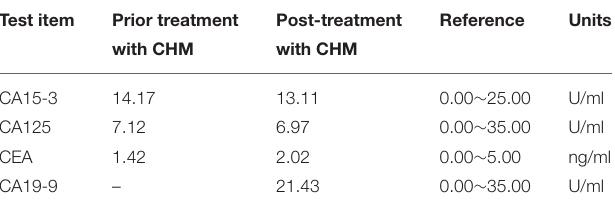
TABLE 1 | Tumor marker